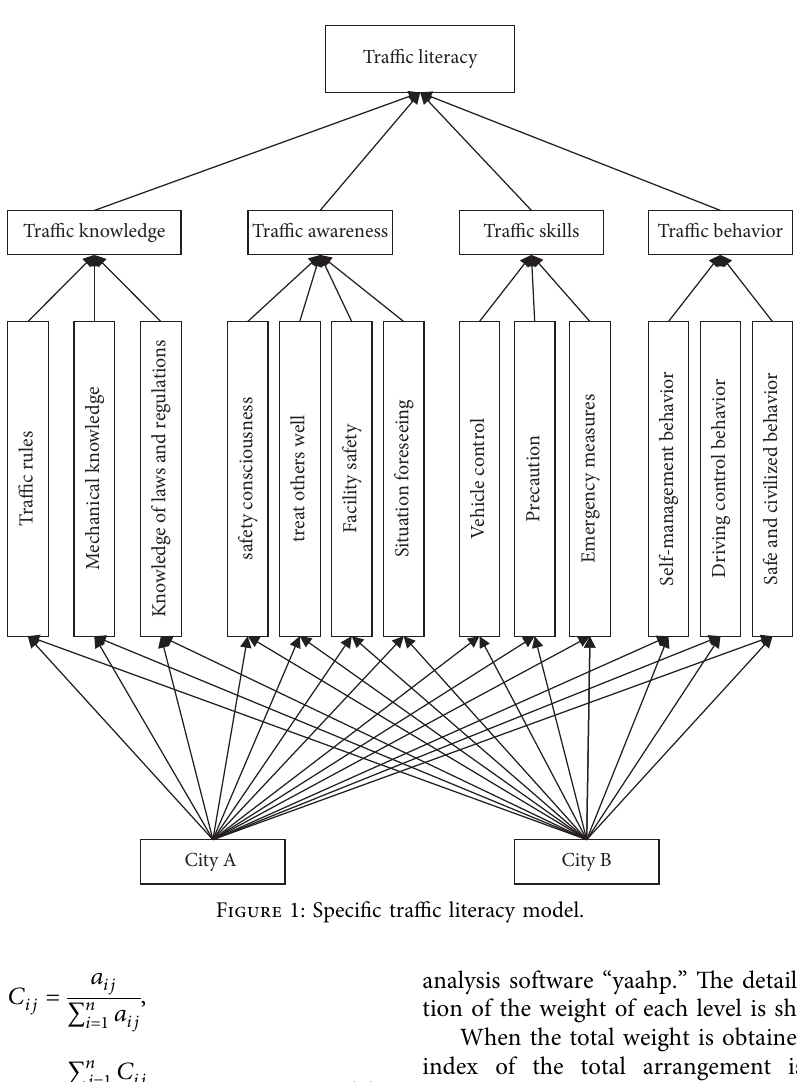
Figure 1: Specific traffic literacy